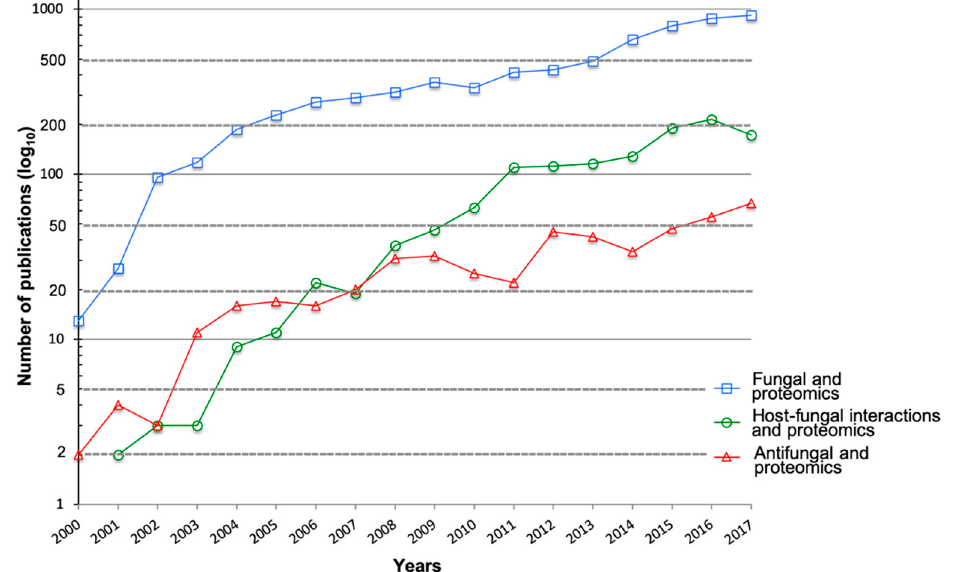
Figure 1. Publications from 2000–2017 of proteomic applications in fungal biology. An in-house developed R-script was used to search PubMed for publications using the following search terms within the abstract and / or title: (i) “fungal OR fungi AND proteomics NOT host”; (ii) “host–fungal interactions OR host–fungi interactions AND proteomics”; and (iii) “antifungal AND proteomics”. Note: y-axis plotted on log 10 scale for improved data visualization.